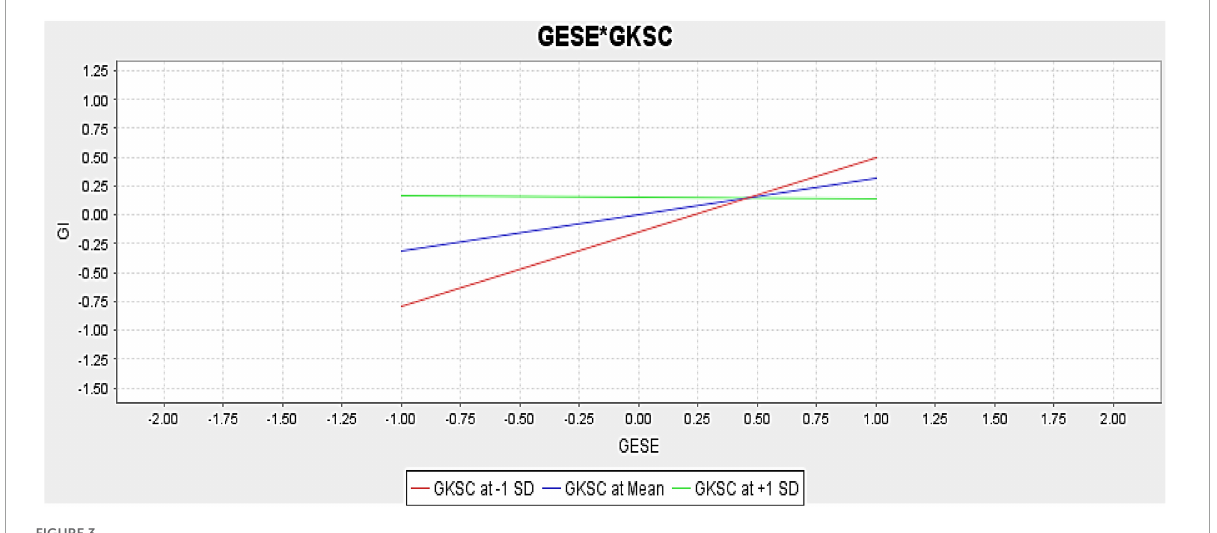
FIGURE3 Moderation slope of green self-efficacy*green knowledge sharing culture.